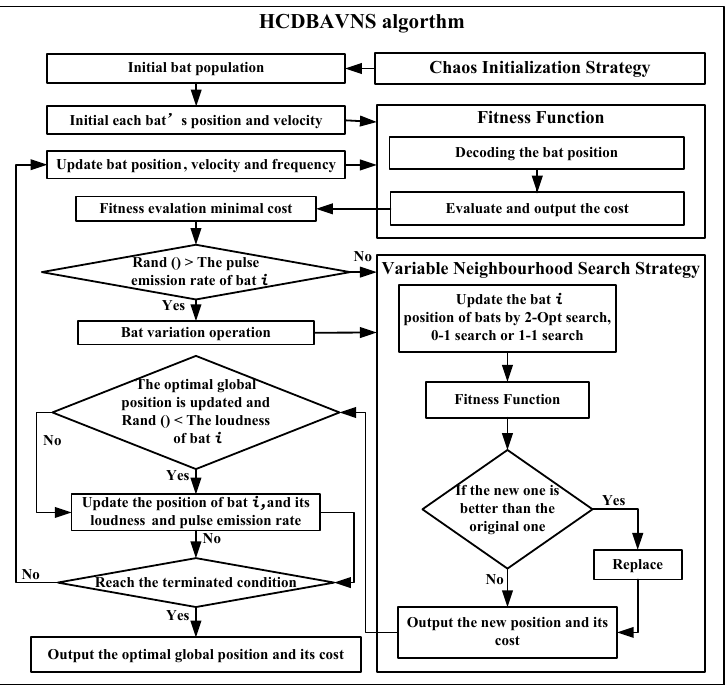
Figure 2. Optimization Framework of